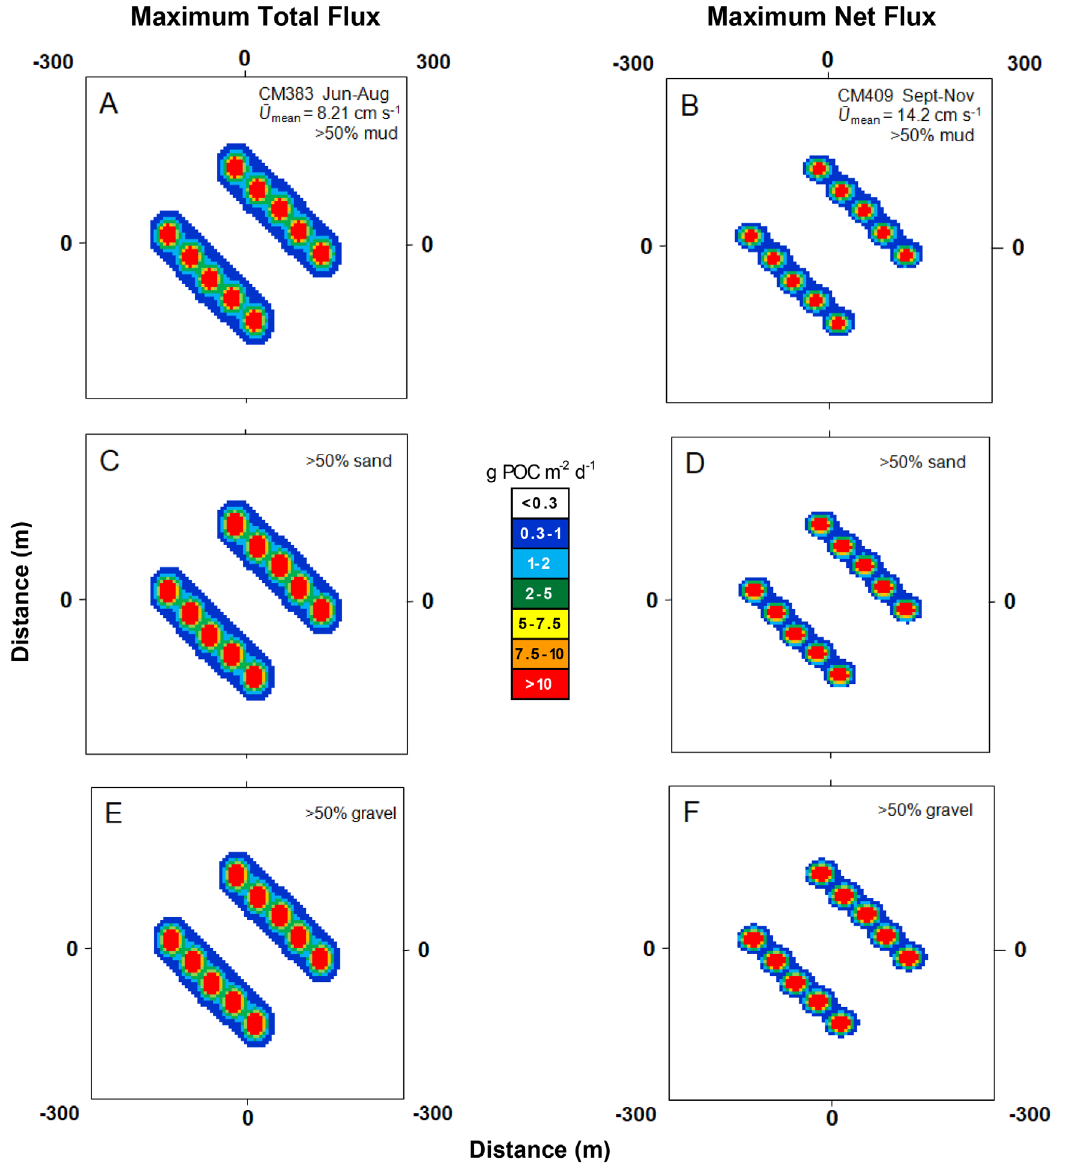
Fig. 8. Model output for 2 enrichment contour intervals and maximum net POC flux under net-pens applying 3 fecal size classes and current statistics from (A,C,E) CM383 and (B,D,F) CM409 modified for net-pen side-wall drag effects (Table 2) for 3 bottom substrate types (A,B) >50% mud, (C,D) >50% sand and (E,F) >50% gravel. Model area is 36 ha with a 6 m grid